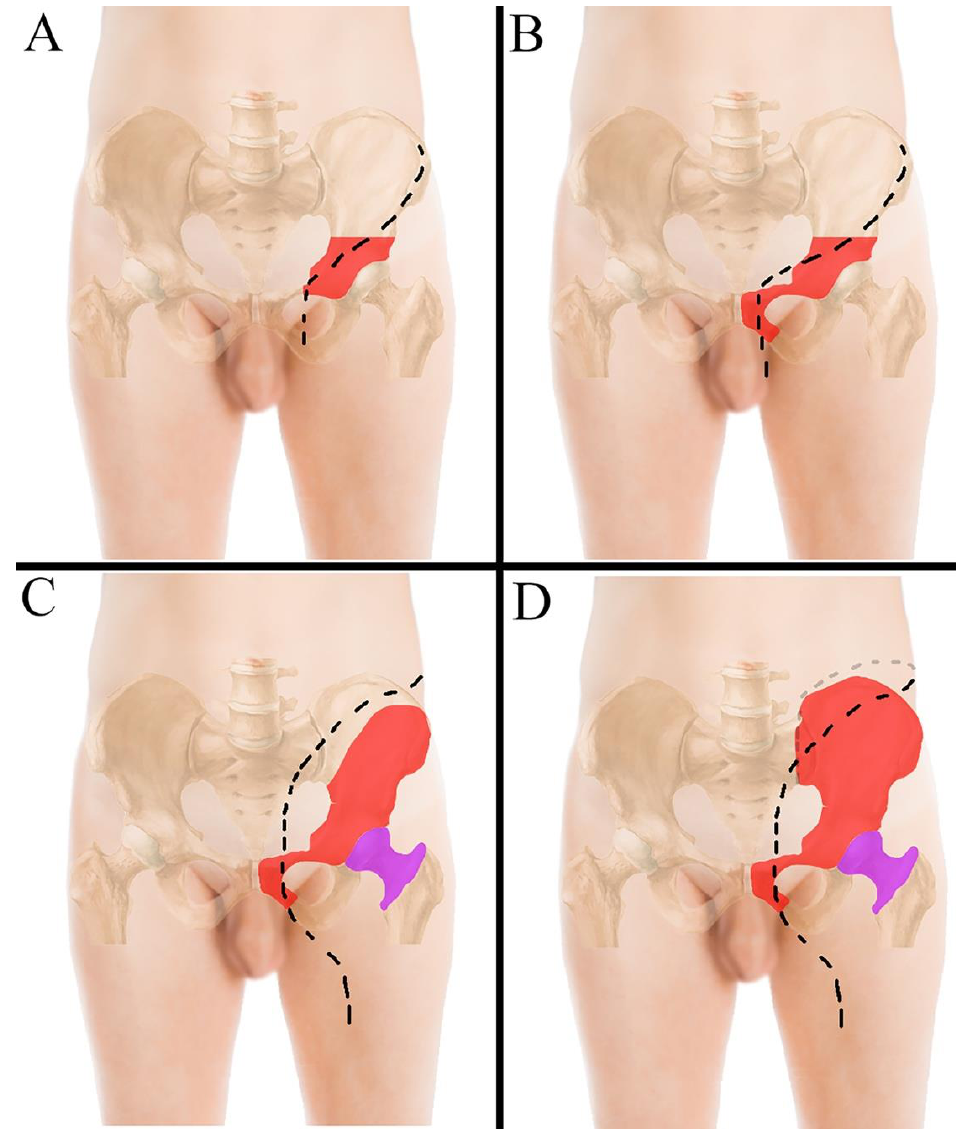
Figure 2. ( A ) ileo-inguinal incision performed to resect tumors located in the acetabular area; ( B ) ileo-inguinal incision performed to resect tumors located in the acetabulum with symphysis involvement; in this case the incision bends slightly proximally to cross the inguinal ligament more medially. ( C ) incision performed to resect tumors located in the iliac wing, the hip and the symphysis; ( D ) incision performed when the tumor also involves the sacrum-iliac joint. The tumor areas in the pelvis and in the femur are drawn in red and magenta, respectively.